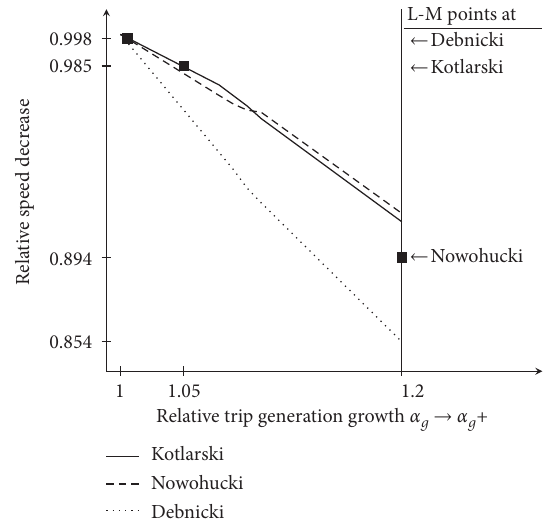
Figure 8: Relative speed decrease on alternative bridges against trip generation growth.